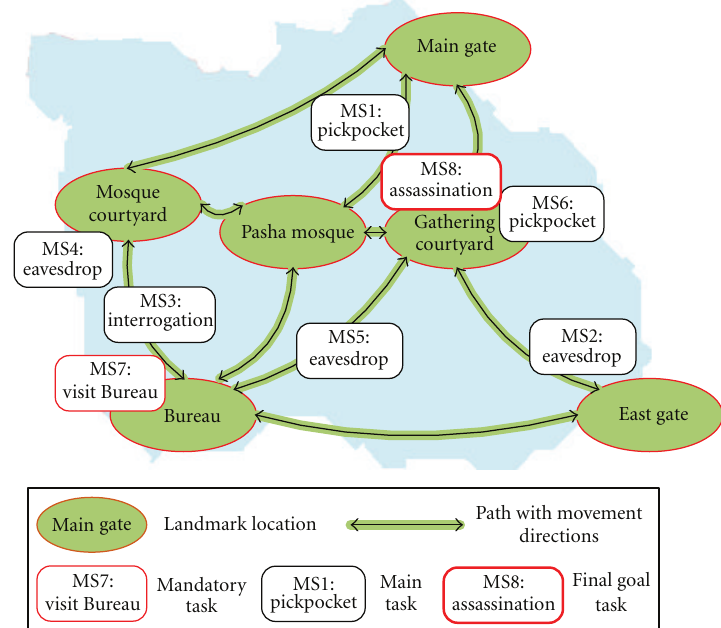
Figure 7: Damascus Poor District: operational